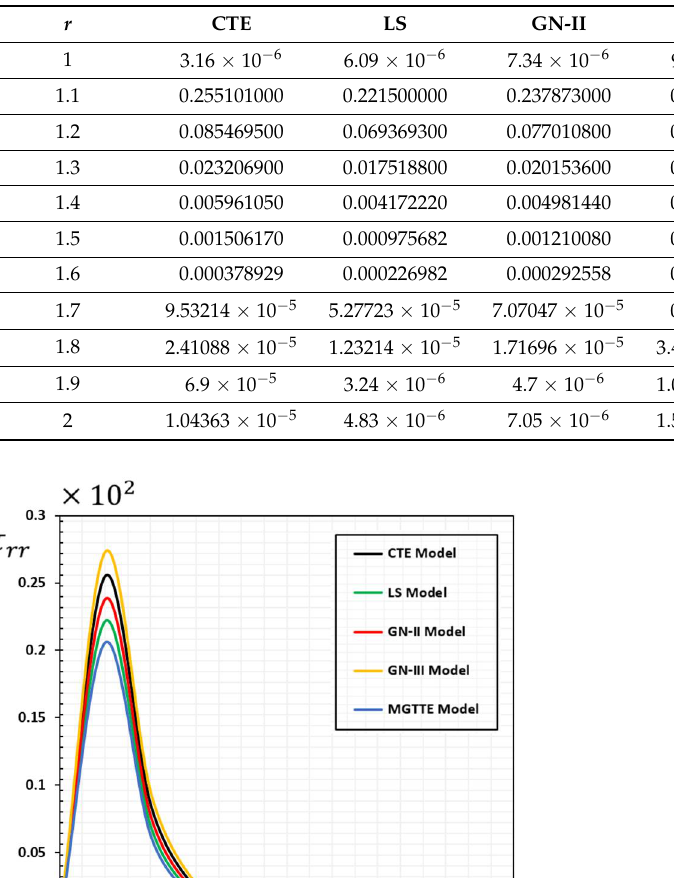
Table 7. The radial Maxwell stress, τ rr , versus different models of thermoelasticity.